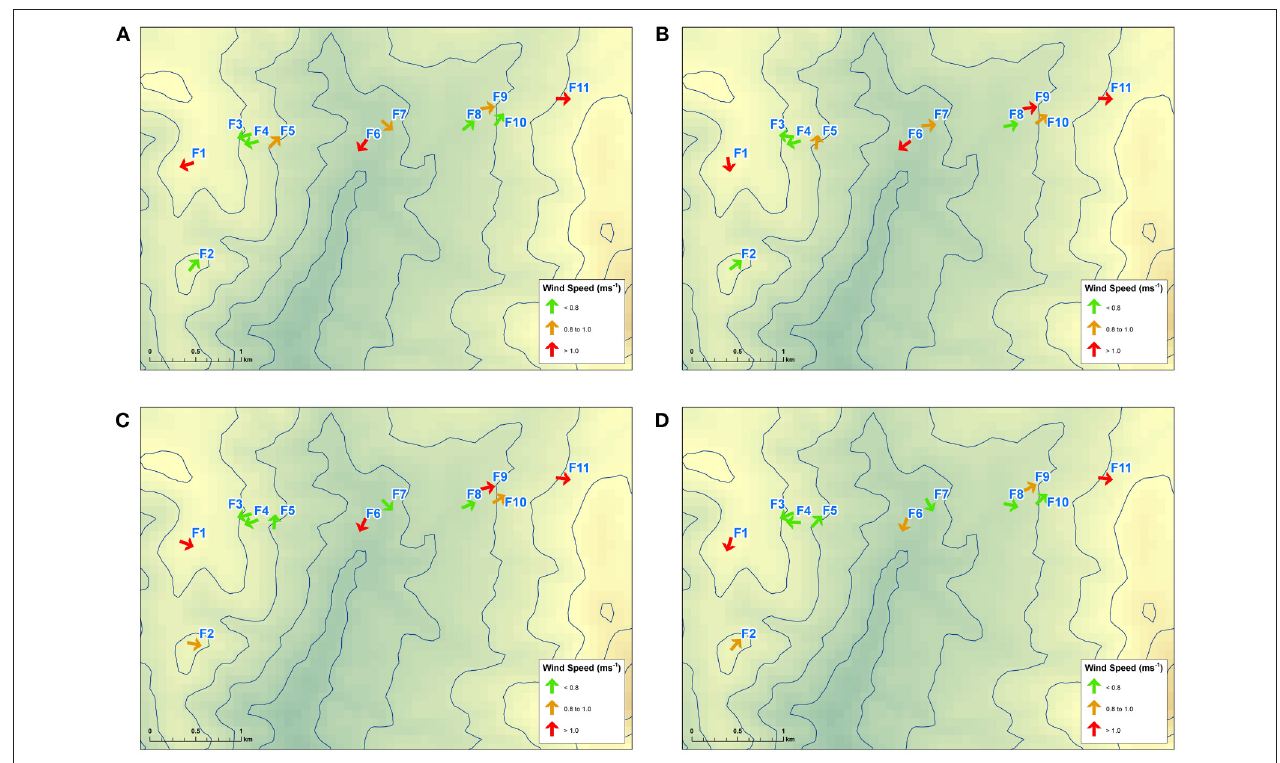
FIGURE 3 | Observed average hourly wind directions at each site across Flea Creek Valley, at (A) 0300 h, (B) 0900 h, (C) 1500 h, and (D) 2100